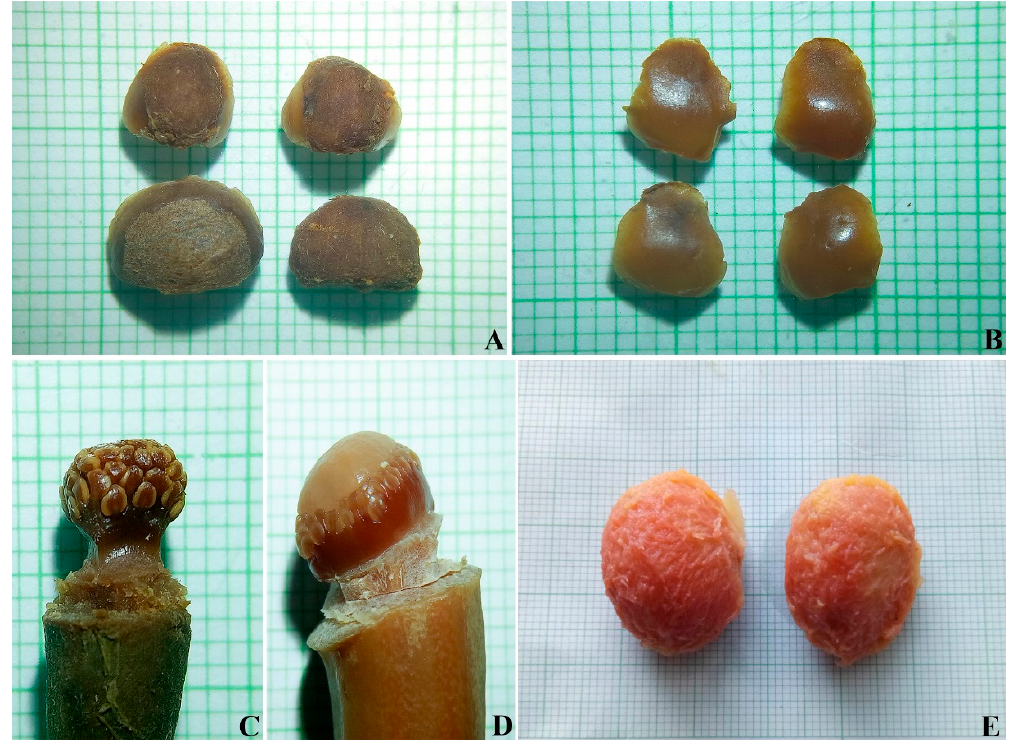
Figure 12. Garcinia pedunculata : ( A ) outer pair of sepals (lower) and inner pair of sepals (upper); ( B ) outer pair of petals (lower) and inner pair of petals (upper); ( C ) male flower showing stamens numerous, united in a central 4-sided column surrounding a pistillode (sepals and petals removed); ( D ) female flower showing pistil and staminodes (sepals and petals removed); ( E ) seeds. Photos: Weereesa Boonthasak.